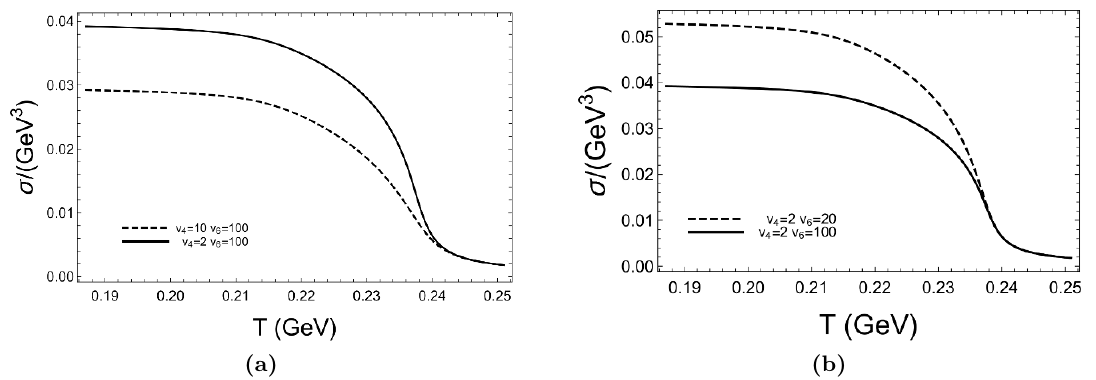
Figure 6. Chiral condensate (cid:27) as a function of the temperature T for (cid:22) = 0 and m q = 5 MeV, with V ( (cid:31); F 2 ) taking the form of eq. (4.8). Panel (a) gives results for v 4 = 2 ; v 6 = 100 (solid line) and v 4 = 10 ; v 6 = 100 (dashed line). Panel (b) gives results for v 4 = 2 ; v 6 = 100 (solid line) and v 4 = 2 ; v 6 = 20 (dashed line). Here, since (cid:22) = 0, the values of (cid:21) 2 ; (cid:21) 4 ; (cid:21) 6 will not a(cid:11)ect (cid:27)